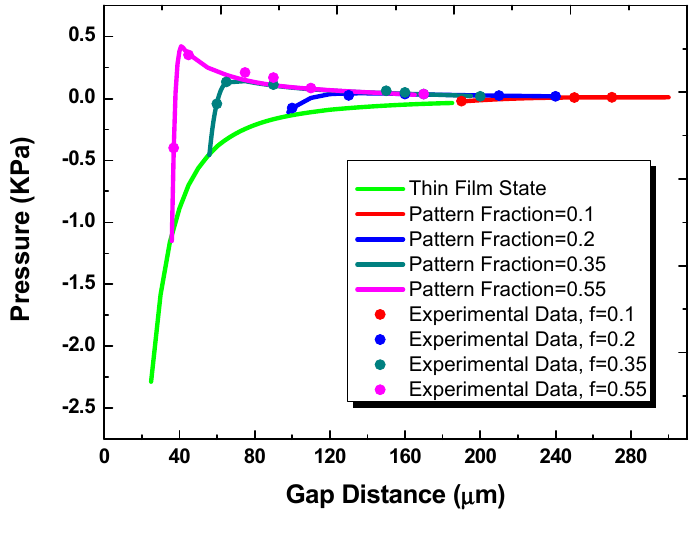
Figure 7. The pressure as a function of gap distance at thin film state and multi-bridge state.